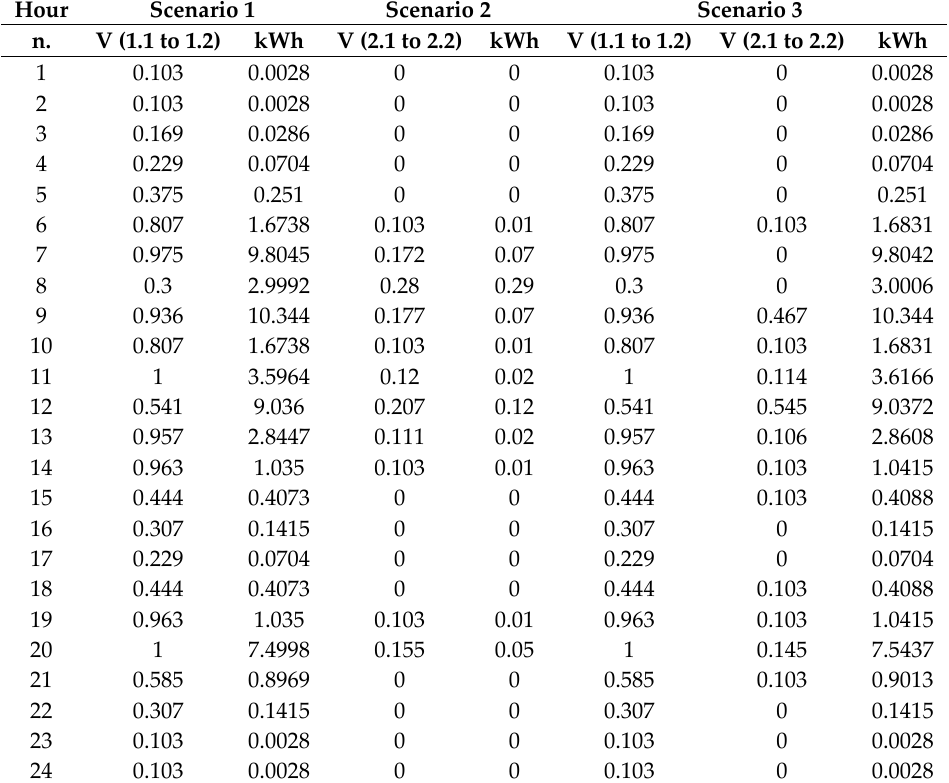
Table 2. Results of the three selected